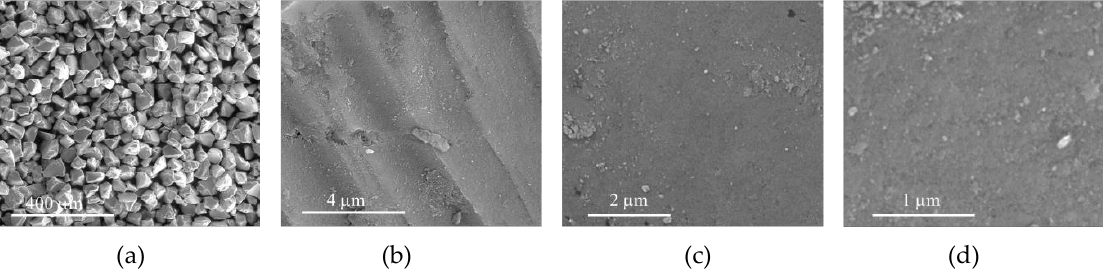
Figure 18. SEM micrographs of CAT-4-Si-H 2 O 2 after 2 cycles in oxidation reactions using H 2 O 2 as the oxidant. ( a ) 250×, ( b ) 25,000×, ( c ) 40,000×, ( d ) 100,000×.